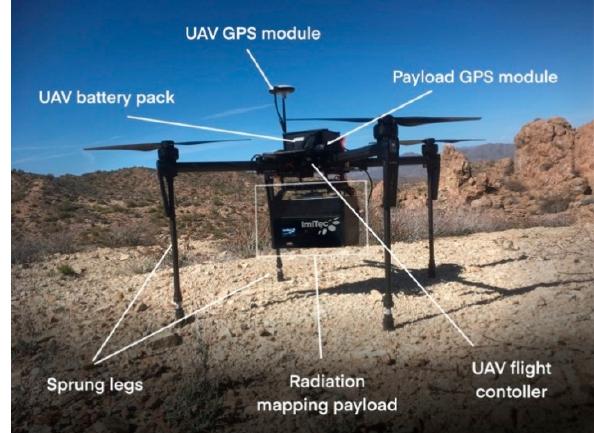
Figure 1. Photograph of the aerial platform consisting of the DJI M100 UAV with attached radiation mapping payload (comprising SIGMA-50 detector, external GPS module, radio datalink, single-point range-finger and associated control